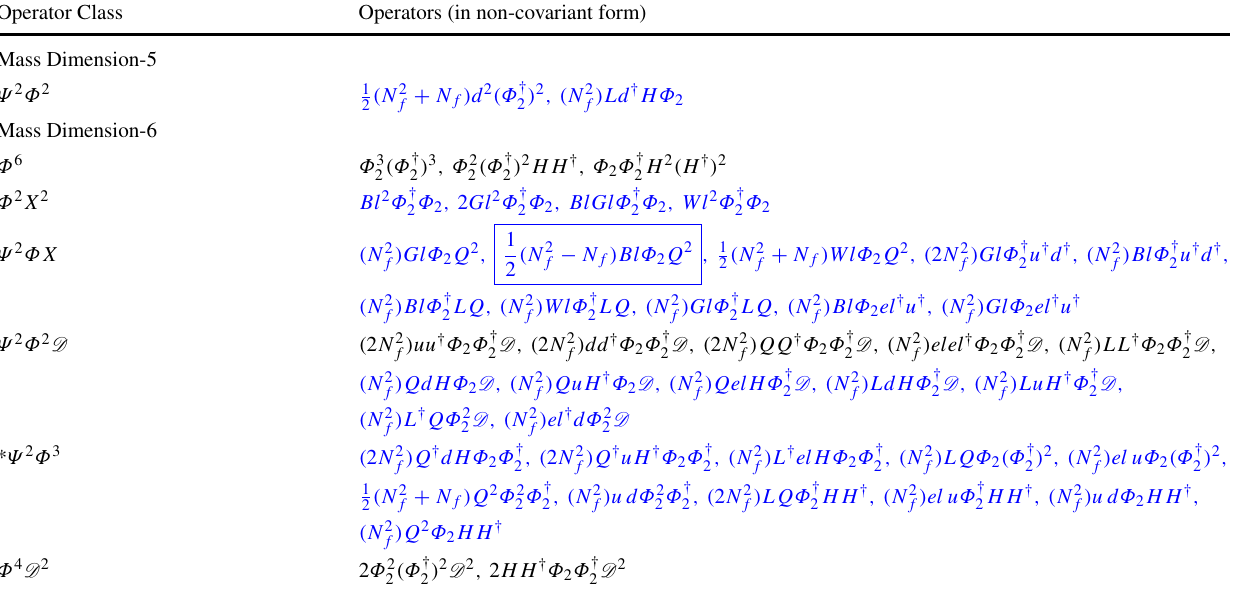
Table 42 Lepto-Quark Model 4( Φ 2 ): Operators of mass dimensions-5 and -6 excluding pure SM operators Operator Class